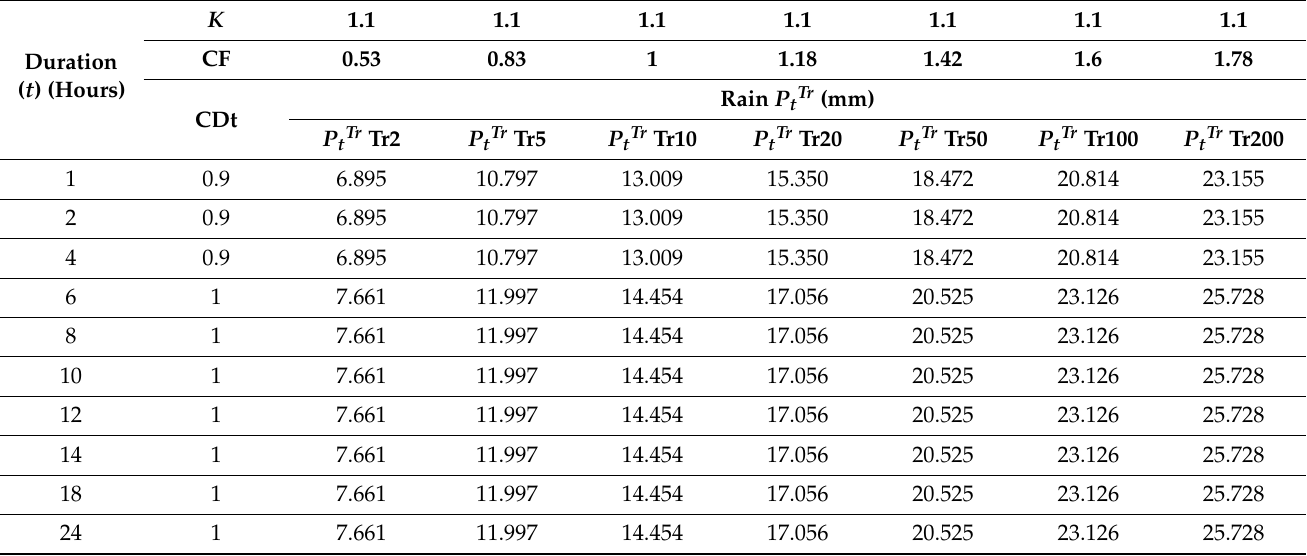
Table 5. Rainfall for different return periods and different duration. Pt Tr is the rain with a return period of Tr years and a duration of t hours on a millimeter scale. K is the correction coefficient. CDt is the duration coefficient for a period of t hours. CFt is the frequency coefficient for a return period of Tr years.